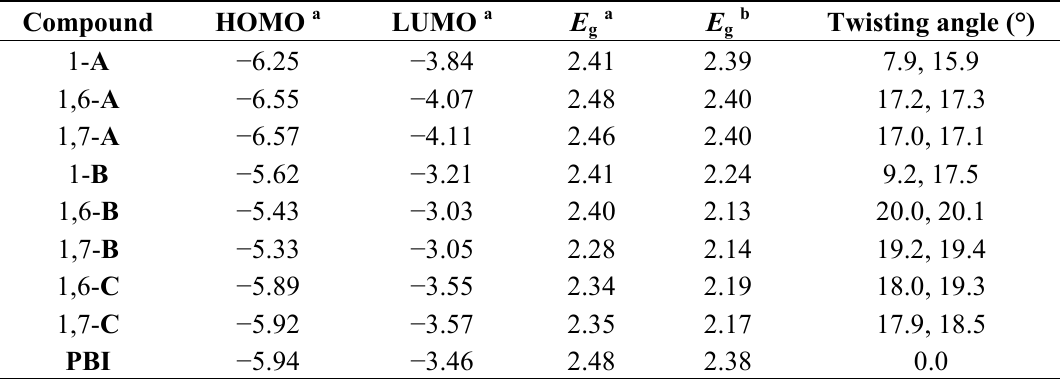
Table 1. Calculated and experimental parameters for perylene bisimide